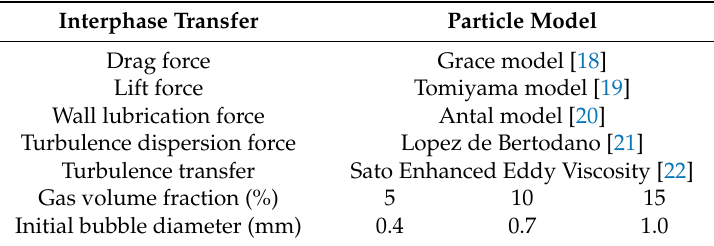
Table 2. The interphase force models and bubble diameter.